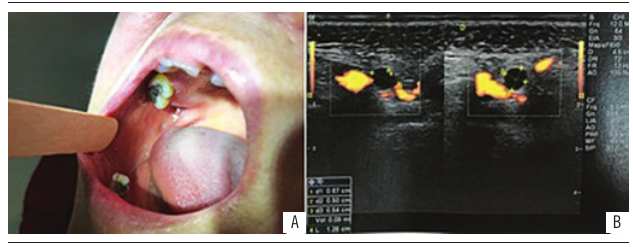
FIGure 1 – Initial image of the patient A) intraoral clinical aspect; B) ultrasonography presenting cyst with heterogeneous content